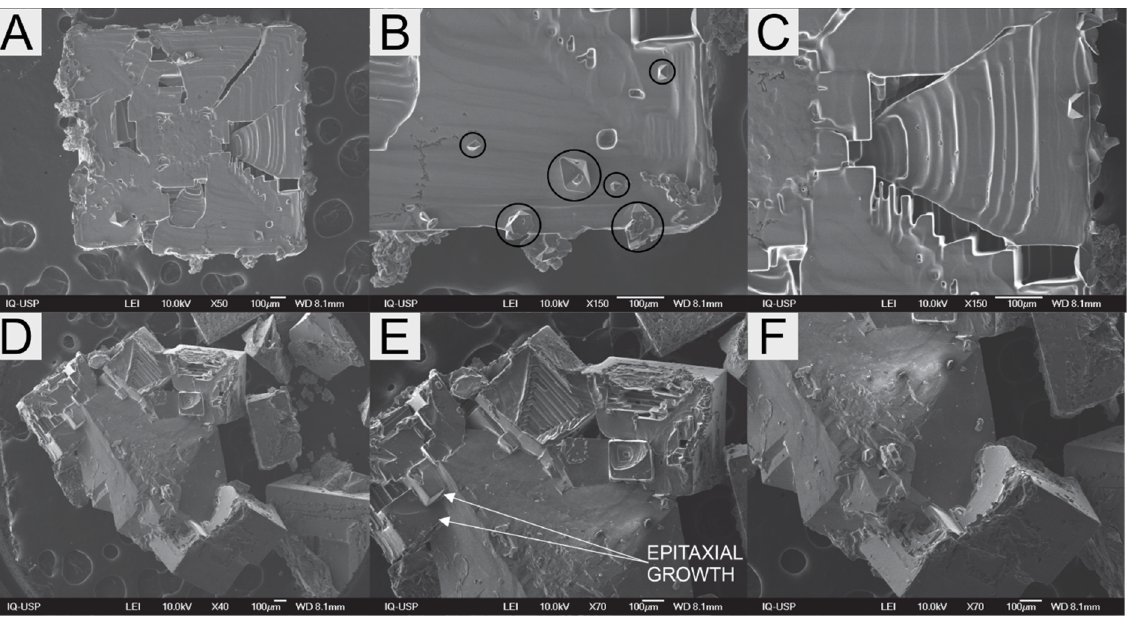
Figure 10. SEM image of ( A ) the NaCl seed grown after 63 min on the NaCl–Na 2 SO 4 –H 2 O droplet under evaporation; ( B ) Na 2 SO 4 crystals on the seed surface; ( C ) a hopper cavity of the seed crystal; ( D ) Na 2 SO 4 seed grown after 58 min on the NaCl–Na 2 SO 4 –H 2 O droplet under evaporation; ( E , F ) epitaxial formations of NaCl crystals on top of the Na 2 SO 4 seed.